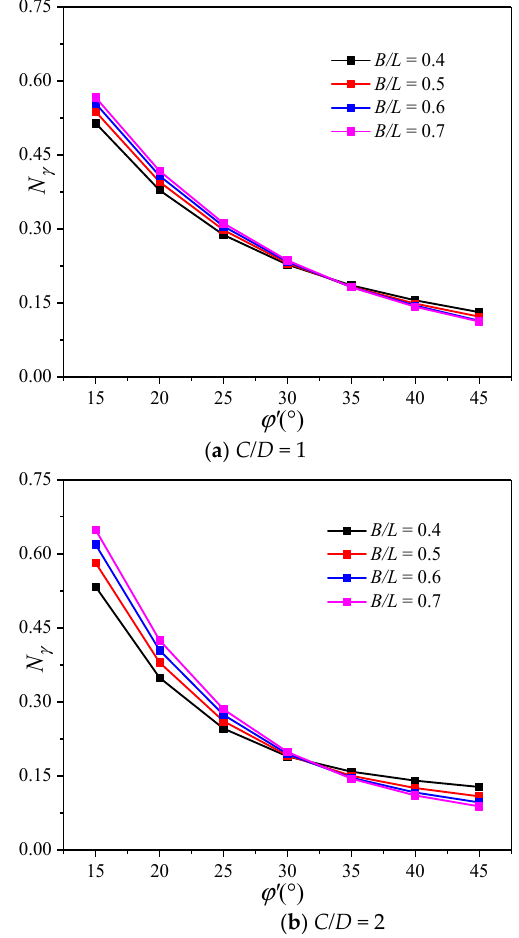
N γ depending on ϕ′ . Figure 13. Variations in N γ depending on ϕ ’